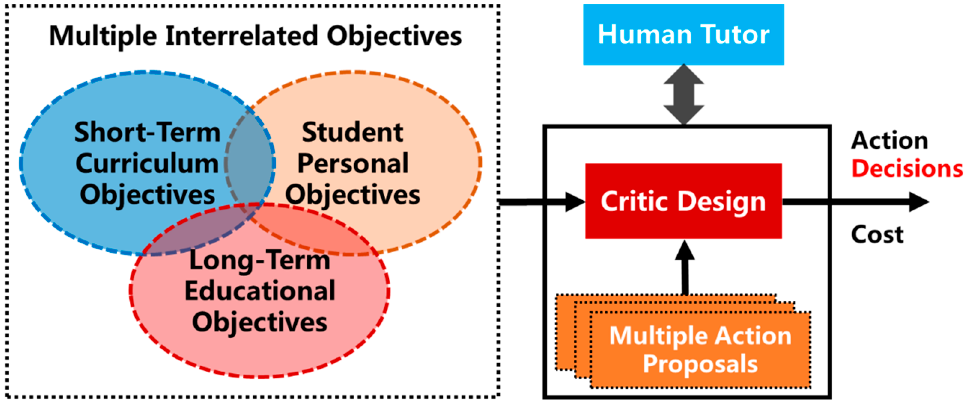
Figure 5. Critic design needs to take into account multiple interrelated objectives and may benefit from human tutor supervision. The critic may select from multiple action proposals before making a decision.